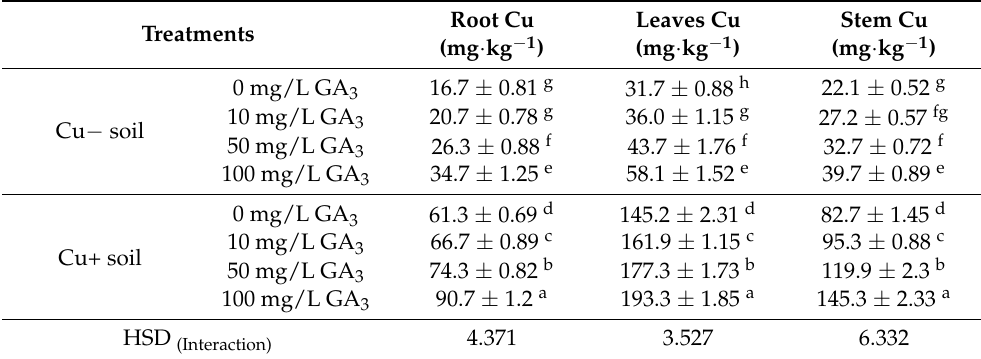
Table 2. Copper concentration in roots, stem, and leaves of peas as affected by exogenous application of GA 3 and Cu contamination of soil.